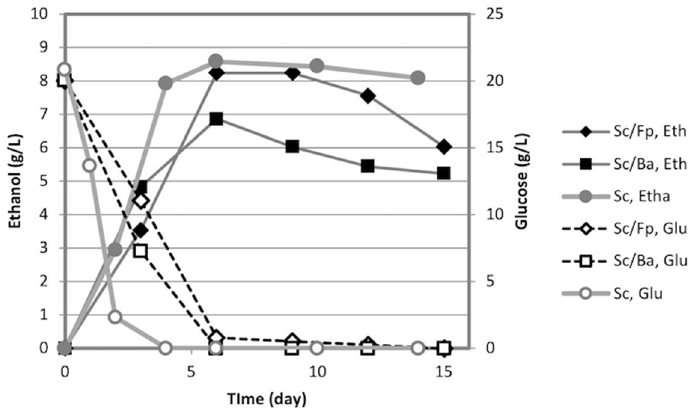
Figure 4. Ethanol production from glucose by mixed culture of S. commune + B. adusta (Sc/Ba) and that of S. commune + F. palustris (Sc/Fp). All tests were conducted under semi-anaerobic conditions.